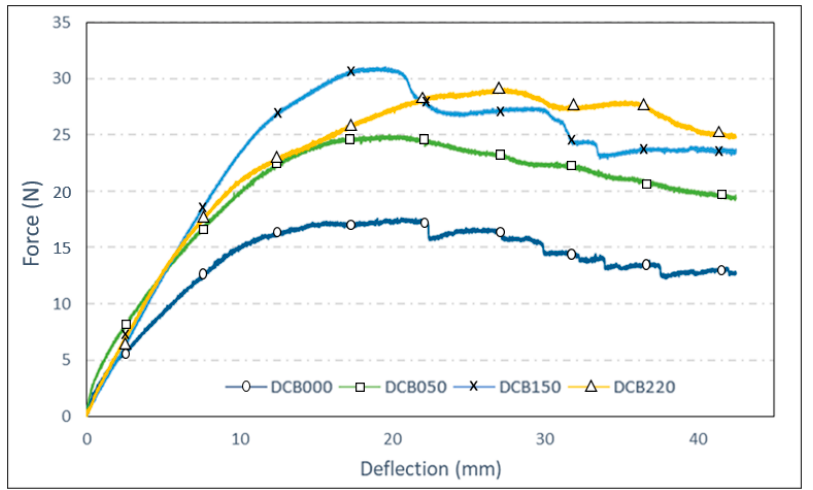
Figure 11. Force-Displacement plots for Mode I tests.